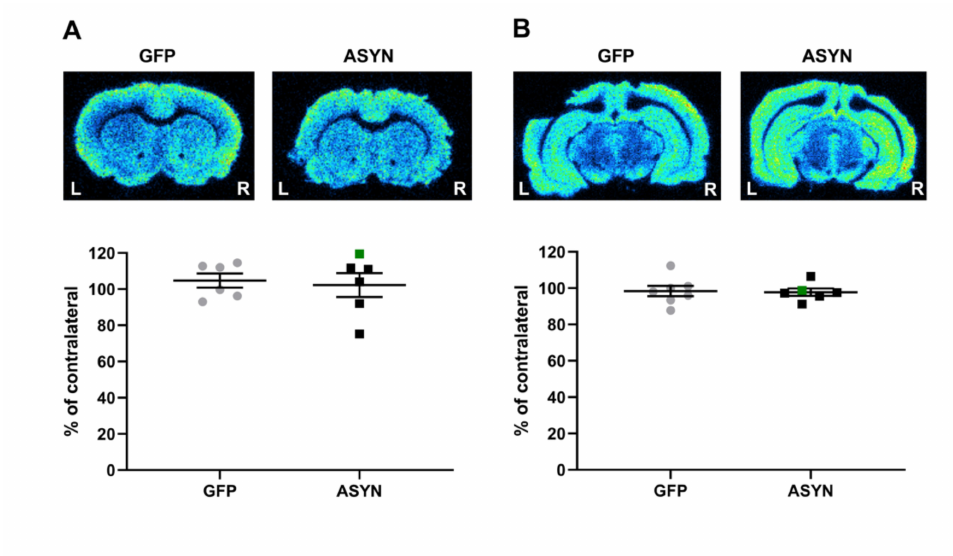
Figure 5. Representative autoradiograms of [ 3 H]UCB-J binding to SV2A in ( A ) the striatum and ( B ) SN. Graphs at the bottom of each panel show the ipsilateral value as percentage of the contralateral binding. The green square represents the rat with lateral ASYN expression in the striatum. Striatum: GFP ( n = 6), ASYN ( n = 7), SN: GFP ( n = 7), ASYN ( n = 7). Data are mean ± SEM. Distance from bregma 0.48 mm and − 5.8 mm in ( A , B ),